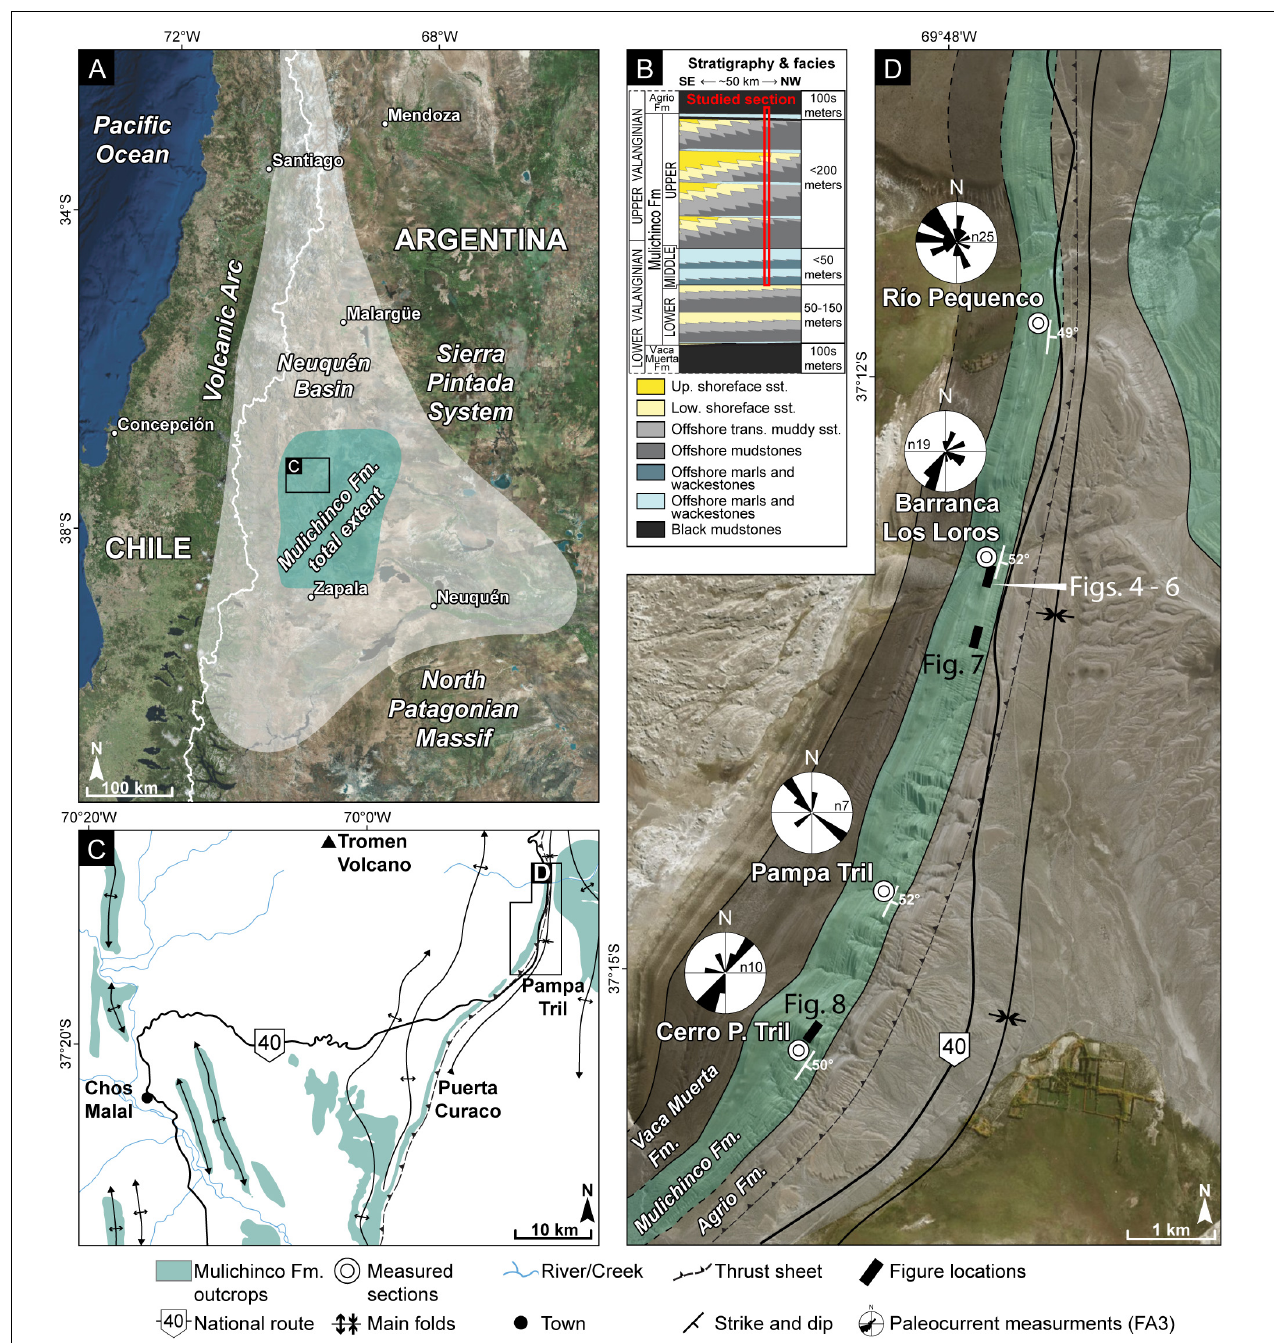
FIGURE 1 | (A) Overview map showing position and lateral extent of the Neuquén Basin, west-central Argentina, approximate extent of Mulichinco Fm. (both in outcrop and subsurface) is indicated, map based on Schwarz (2012). (B) Stratigraphic column modified from Schwarz (2012), approximate thicknesses adapted from Schwarz and Howell (2005; Figure 11a , p. 127). (C) Map showing Mulichinco Fm. outcrop distribution adjacent to the study area, main elements of the Chos Malal fold and thrust belt indicated, modified from Schwarz and Howell (2005). (D) Map of studied outcrop with geologic information and location of measured